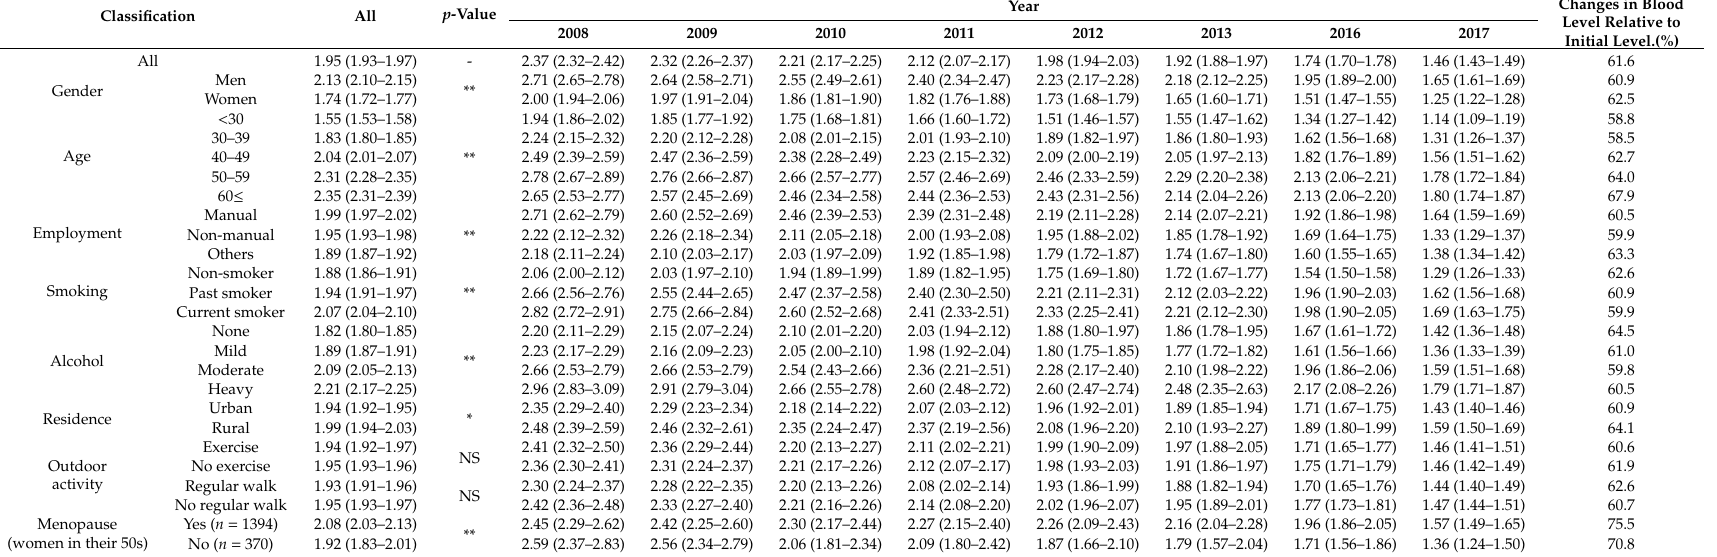
Table 2. Adjusted # geometric means and 95% CI of blood lead according to classification variables in representative Korean